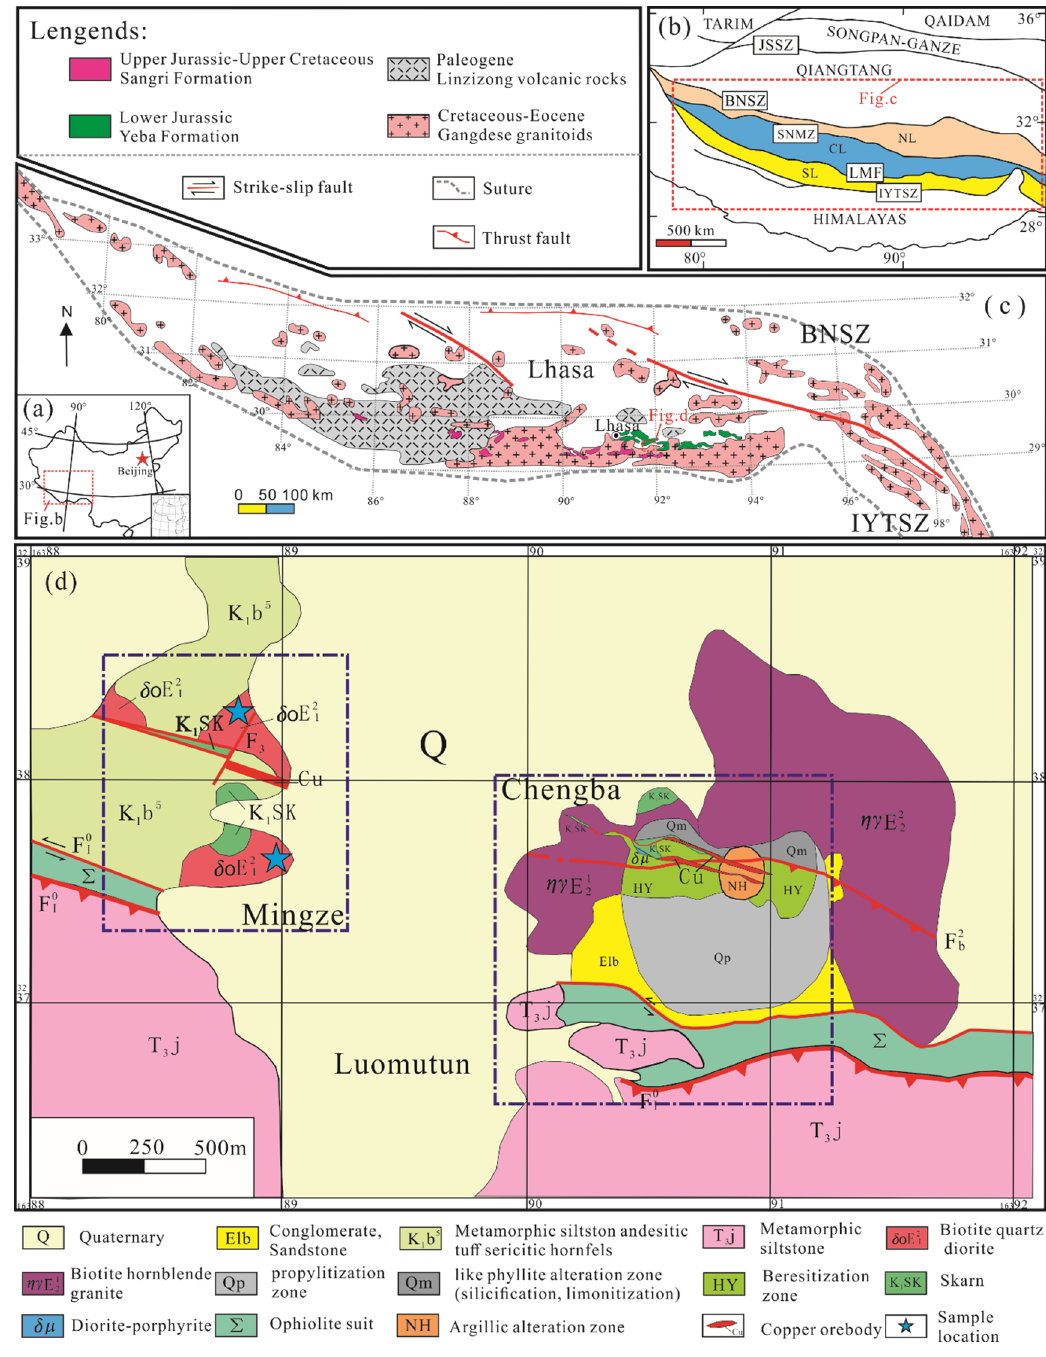
Figure 1. ( a – c ) Simplified geological map of the Tibetan Plateau and magmatic rocks in the Lhasa Block of southern Tibet (modify from [20] and references therein). ( d ) Geologic sketch map of the Mingze skarn Cu–Mo deposit (modified from No.2 Geological Institute of the China Metallurgical Geology Bureau (CMGB), 2011). Abbreviations: SL = Southern Lhasasub-block, CL = Central Lhasa sub-block, NL = Northern Lhasa sub-block, IYTSZ = Indus-Yarlung Tsangpo Suture Zone, LMF = Luobadui-Milashan Faul, SNMZ = Shiquan River-Nam Tso Mélange Zone, BNSZ = Bangong-Nujiang suture zone JSSZ = Jinsha suture zone.